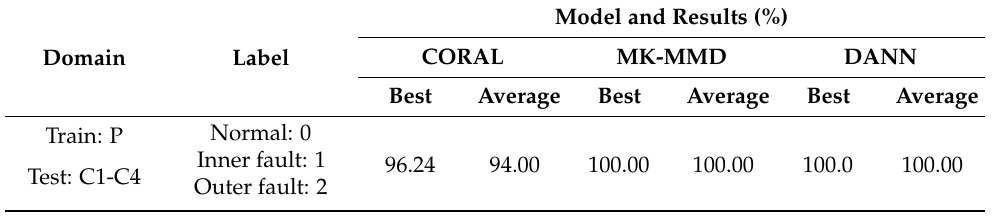
Table 6. Classification results of case 3